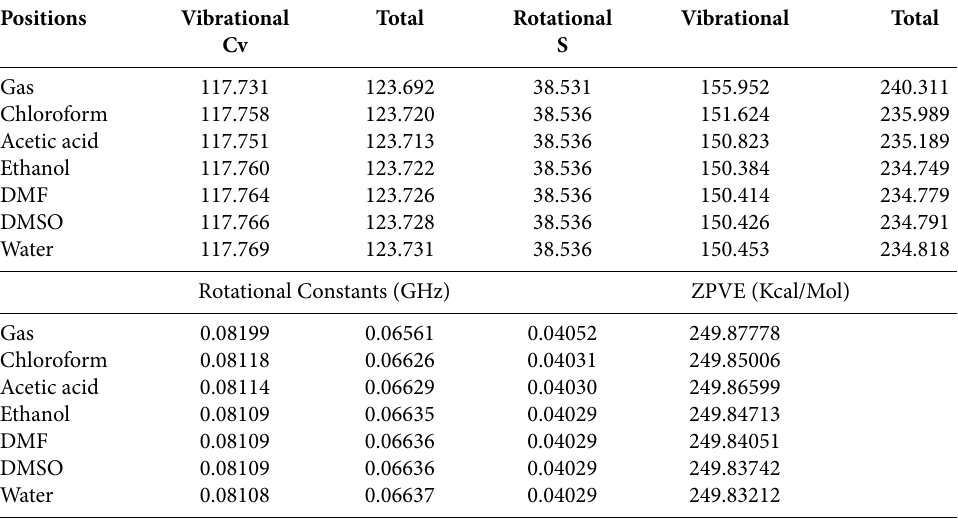
Table 4. Thermodynamic properties of the optimized Iopamidol molecule in the gas phase and different solvents. Positions